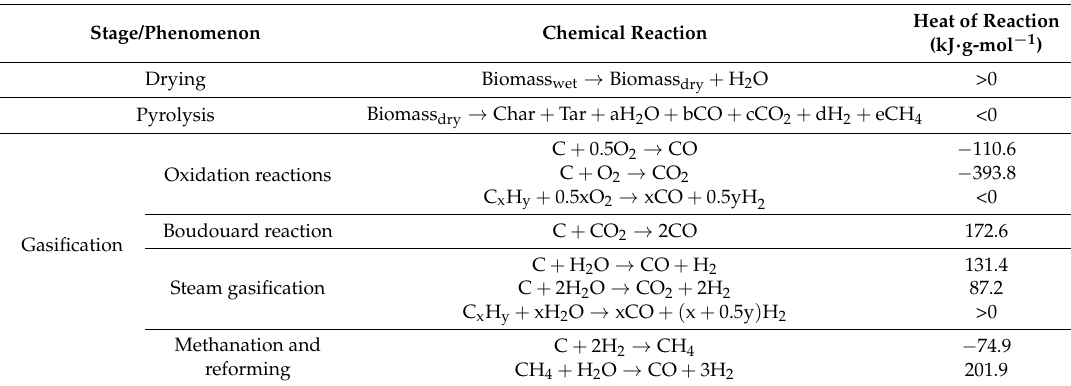
Table 3. Gasification reactions description (Extracted from